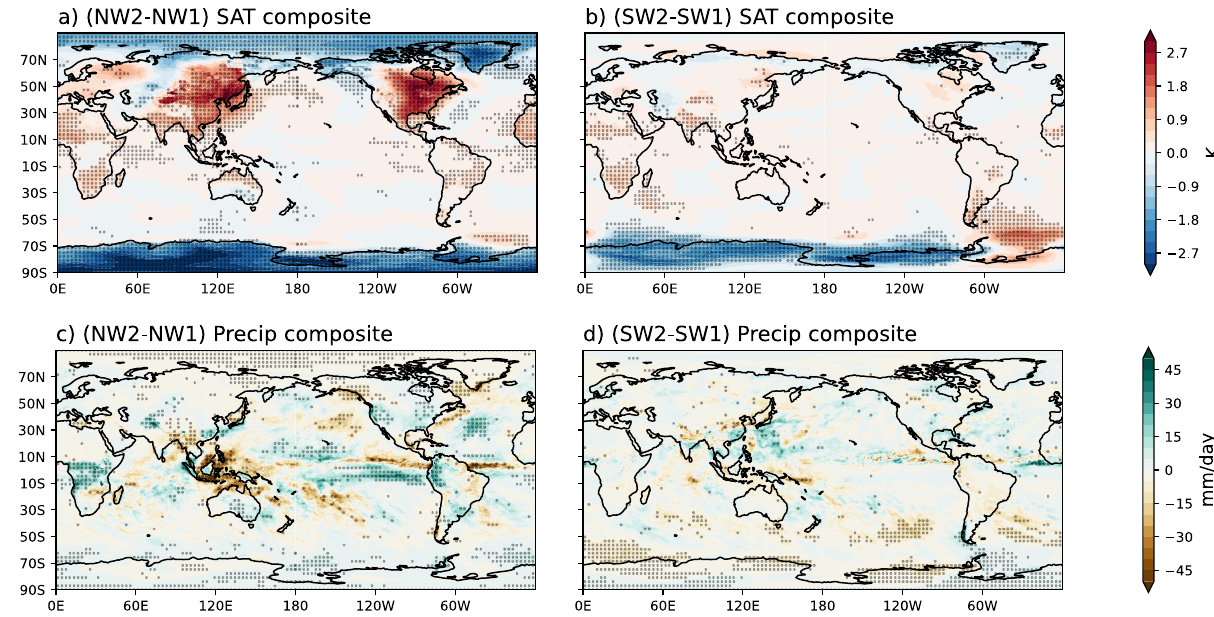
Fig. 7 Surface air temperature and precipitation composites. As in Fig. 5 but for ( a , b ) SAT ( o C) and ( c , d ) precipitation (mm day − 1